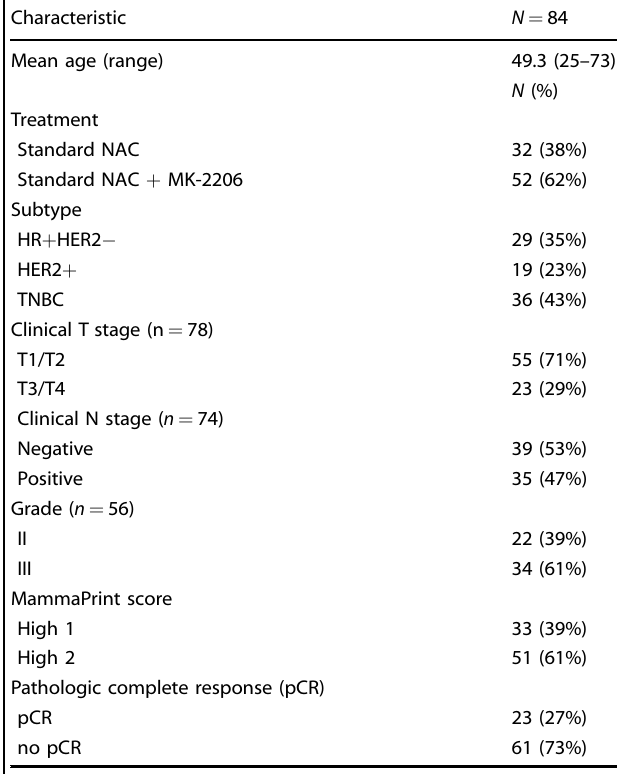
Table 1. Patient and tumor